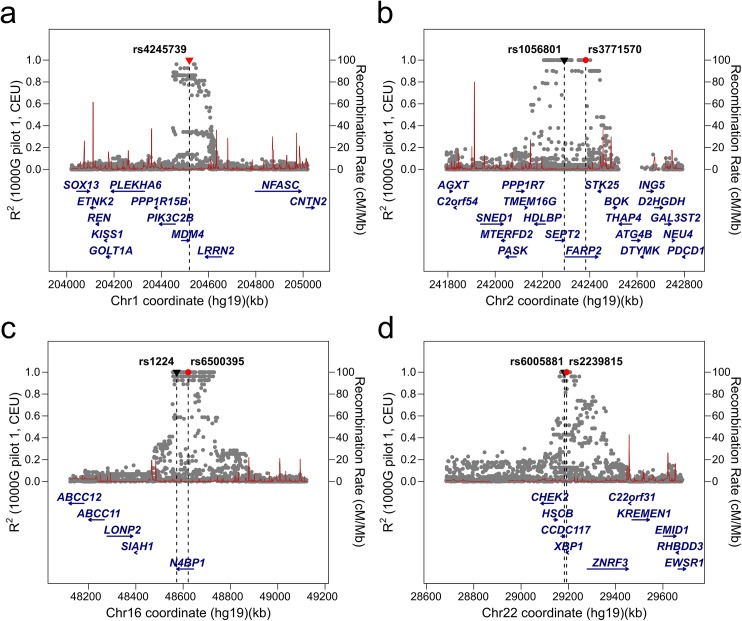
Regional LD plots for the four C-type MRE-SNPs overlapping with the GWAS Catalog.